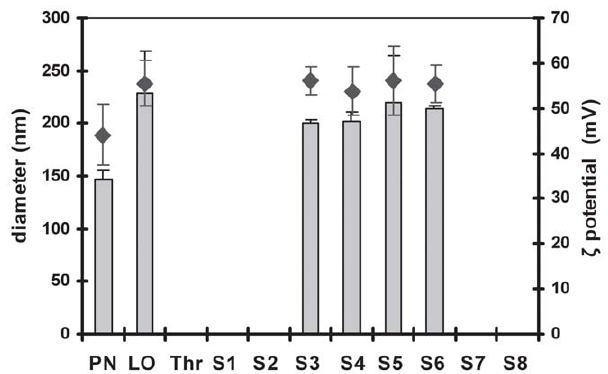
Figure 3. Geometric diameters and electrokinetic potentials ( f ) of RTNs before and after nebulisation through the NGI. The aliquots of the same samples nebulised through the NGI (as in Figure 2A) were used to measure the size (bars) and the f potential (diamonds) using the Malvern Nano ZS Zetasizer. The average values of three independent measurements per each sample were automatically performed. Results of two independent experiments 6 the standard deviation, from samples providing accurate readings are shown: PN=pre-nebulisation RTN suspension; LO=(leftover) RTNs retained in the nebuliser chamber upon completion of the nebulisation and samples from stages 3–6 of the NGI.